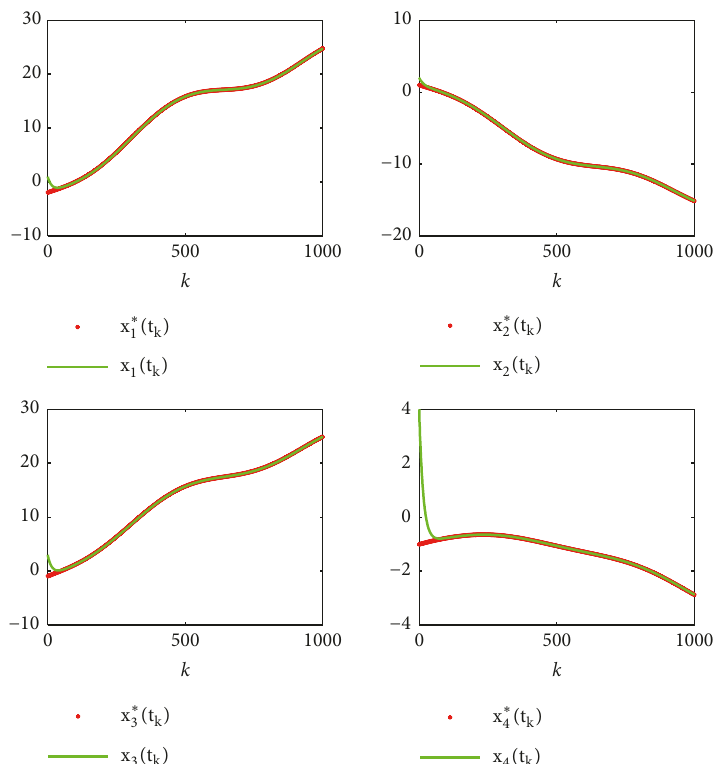
Figure 3: Trajectories of 𝑥 ∗ 𝑖 (𝑡 𝑘 ) (𝑖 = 1, 2, 3, 4) and 𝑥 𝑖 (𝑡 𝑘 ) (𝑖 = 1, 2, 3, 4) generated by the DTZNN models (14) and (18) and their difference for problem (50).